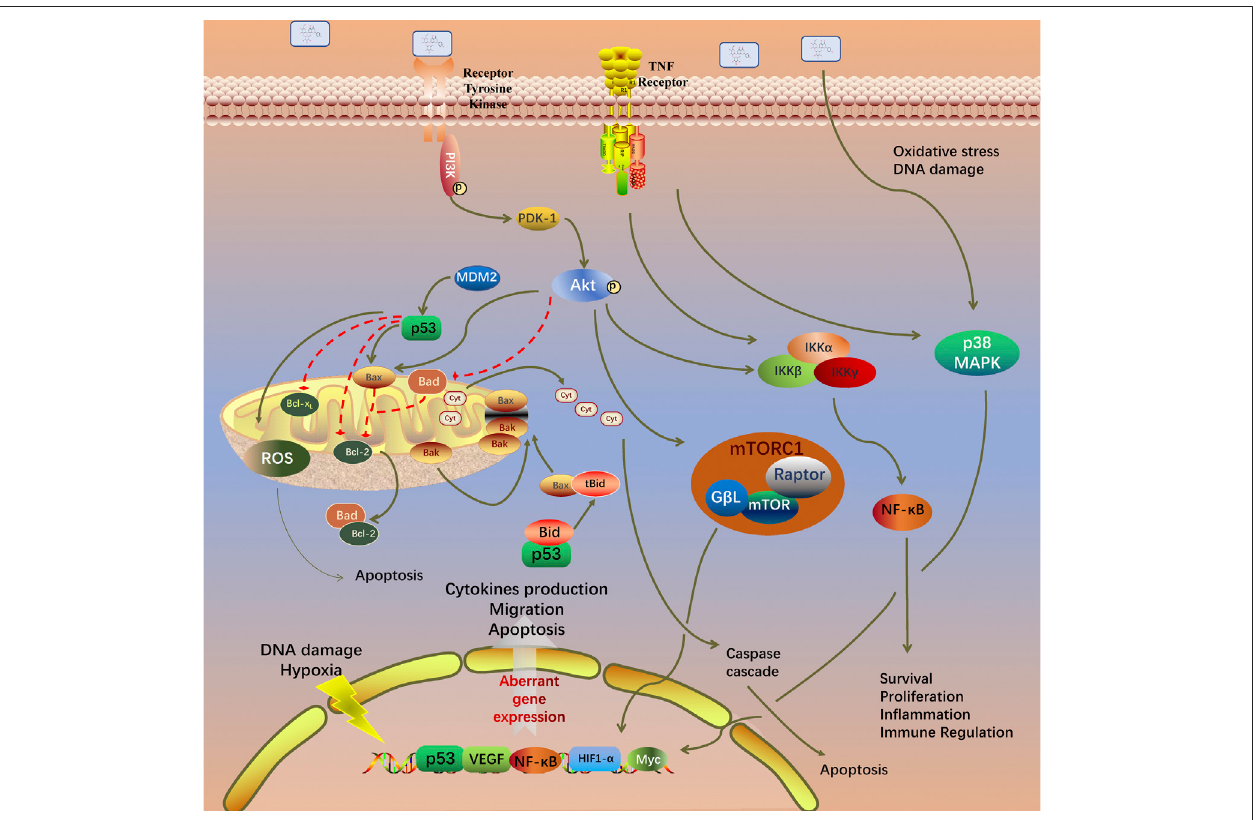
FIGURE 4 | Potential naringin pathway constructed in the present research. Abbreviations: TNF- α , tumor necrosis factor alpha; TNFR, tumor necrosis factor receptor;TRADD,tumornecrosisfactorreceptortype1associateddeathdomainprotein;FADD,Fasassociated via deathdomain;PI3K,phosphatidylinositol3-kinase; PDK1, pyruvate dehydrogenase kinase 1; AKT, protein kinase B; MDM2, murine double minute2; Bcl-2, B-cell lymphoma-2; Bax, BCL2 associated X; BAD, BCL2 associated agonist of cell death; BIM, BCL2-like 11; Bak, BCL2 antagonist/killer; BID, BH3 interacting domain death agonist; MAPK1, mitogen-activated protein kinase 1; NF- κ B, nuclear factor kappa B. BH3, Bcl-2 homology domain; CytoC, cytochrome C; ROS, reactive oxygen